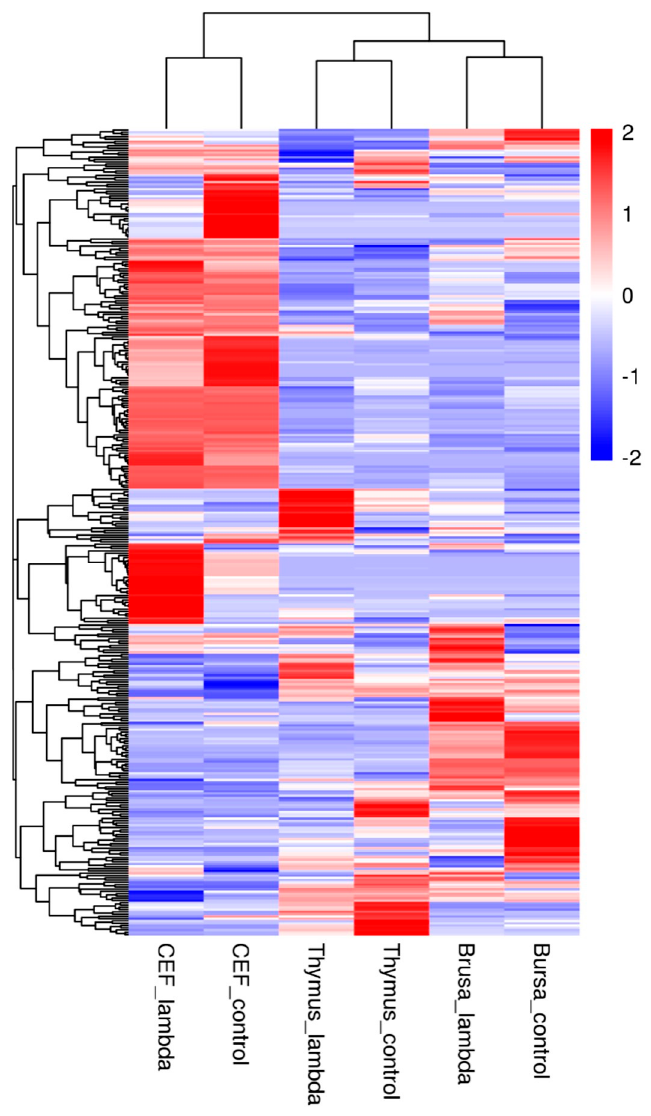
Figure 3. Heat map of DEGs in the CEF, bursa, and thymus. The color bar represents the level of differential expression compared to the control (PBS).